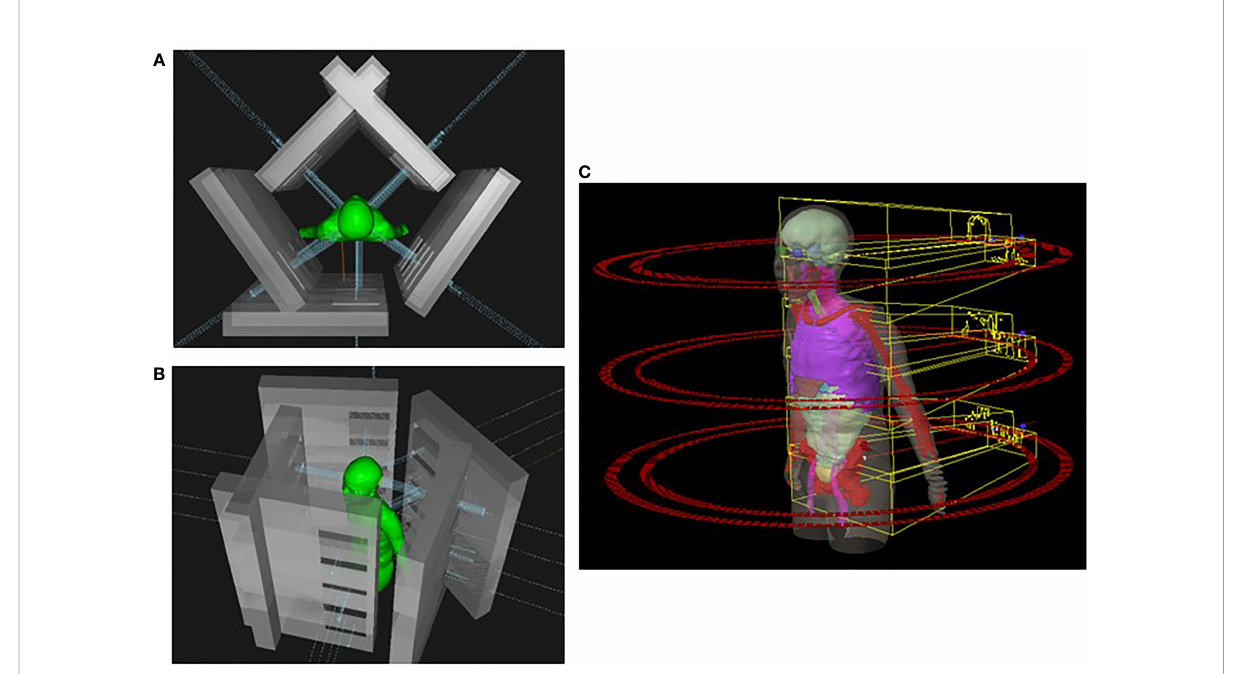
FIGURE 1 (A) Head-to-toe view of IMPT plan taken from Raystation planning system. Five beams were used for each isocenter in this example. (B) Side view of IMPT plan. (C) Representation of a VMAT-TMI plan with arcs and isocenters from Eclipse planning system. IMPT, intensity-modulated spot-scanning proton therapy; VMAT, volumetric modulated arc therapy; TMI, total marrow